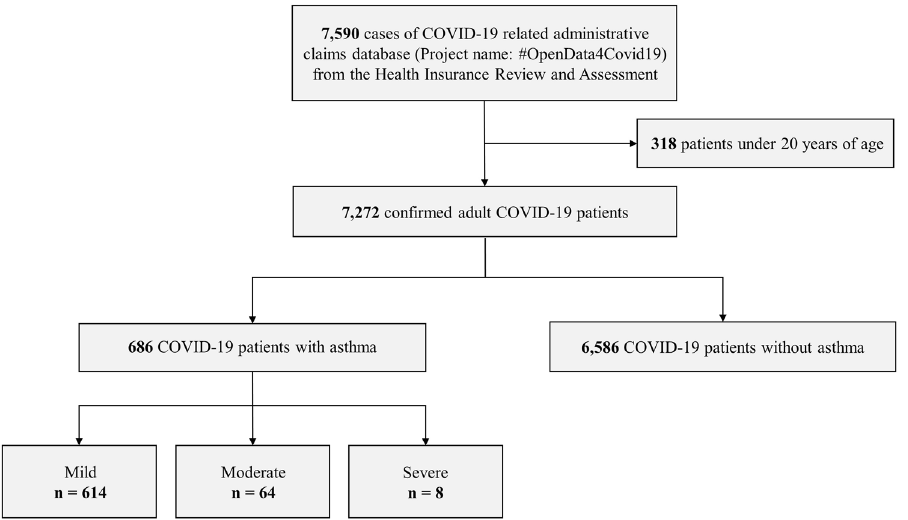
Figure 2. Flowchart of the study population. A total of 7590 coronavirus disease (COVID-19) patients were identified using the 10th revision of the International Statistical Classification of Diseases and Related Health Problems (ICD-10) diagnosis code. Among 7272 adult patients ≥ 20 years of age, 686 patients with asthma were identified using the ICD-10 code and medication use for asthma. Severity of asthma was classified according to the type of medication prescribed. COVID-19, coronavirus disease.